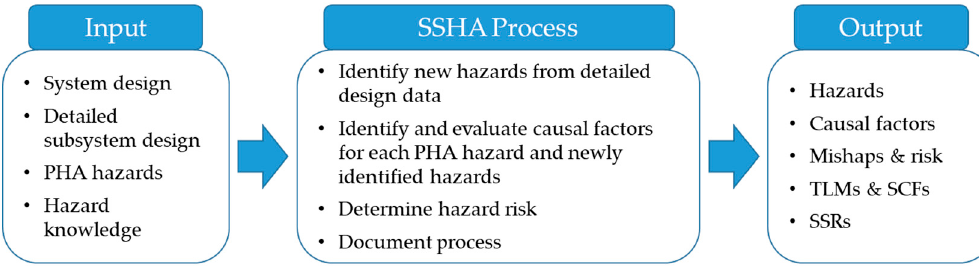
Figure 1. Overview of the subsystem hazard analysis (adapted and redrawn from [27]).